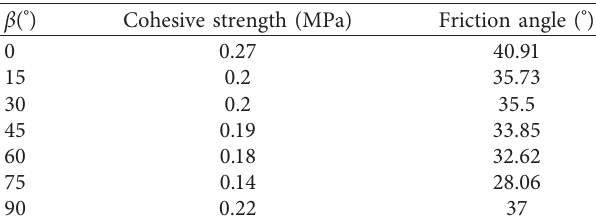
Figure 10: (a) Outcrop of Yanshan open pit and the location of N26 exploration line. (b) Contouring plot of discontinuity orientation. (c) Photo of the planar sliding. Table 4: Mechanical parameters of layered rock mass